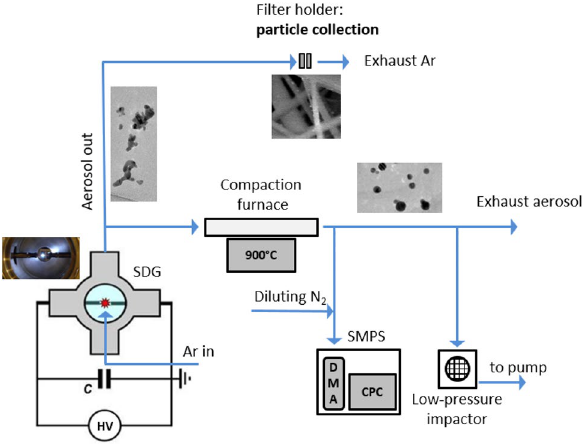
Figure 7. Schematic figure of the particle generation, collection and sampling